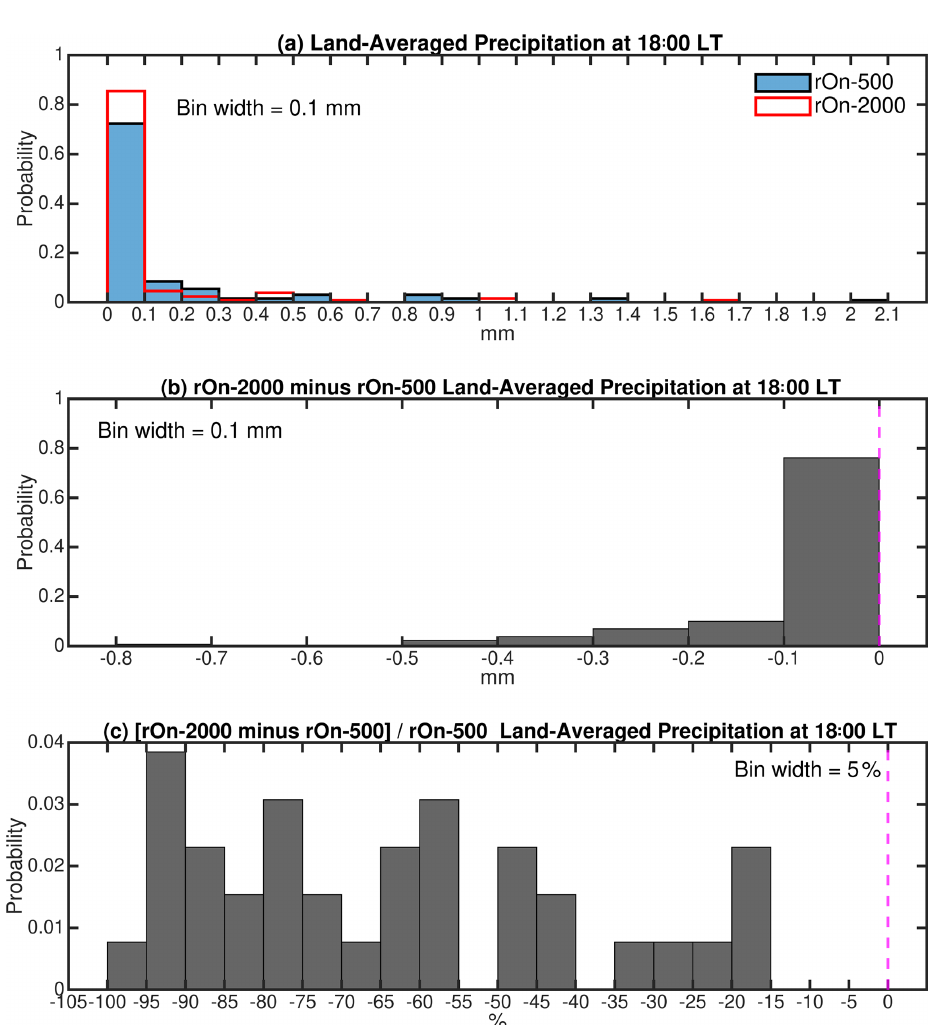
Figure 10. (a) A histogram of the land-averaged accumulated surface precipitation at sunset (18:00LT) in rOn-500 (blue) and in rOn-2000 (red) for simulations that produce at least 0.1mm of the land-averaged accumulated precipitation in rOn-500. The absolute and percent differences between rOn-500 and rOn-2000 are shown in panels (b) and (c) , respectively, where the percentage differences are with respect to rOn-500. The dashed magenta line in panels (b) and (c) indicates where the difference between rOn-2000 and rOn-500 is zero. The bin width of the histogram is marked in each